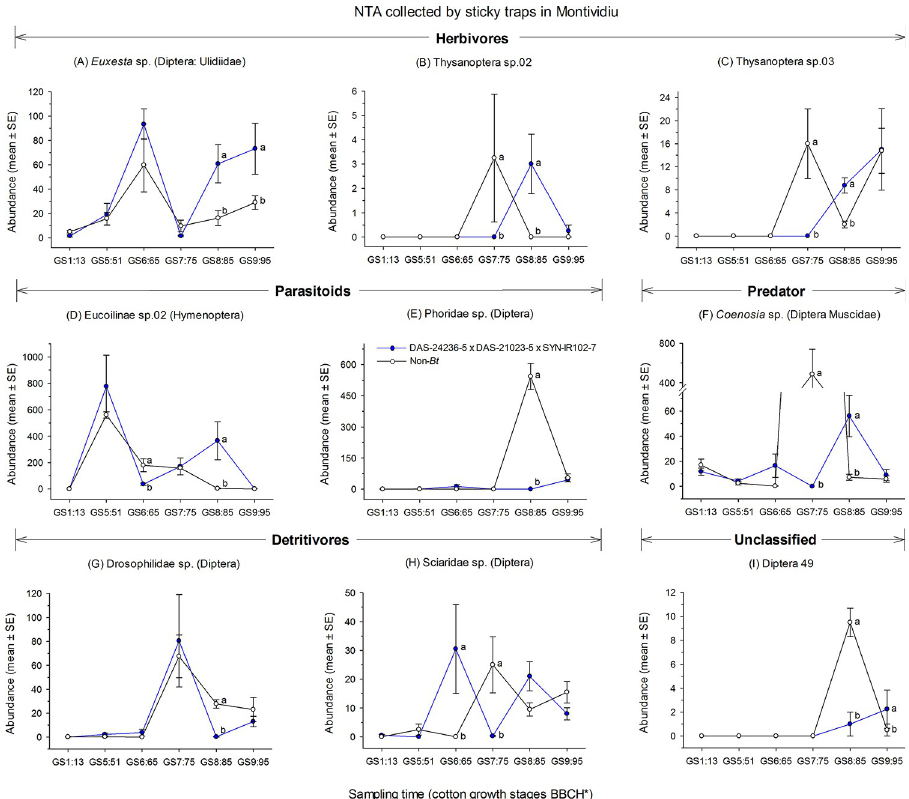
Fig 8. Abundance of aerial-dwelling arthropods collected via sticky card trapping in a cotton trial at Montividiu (2014/2015 cropping season). Means ( ± SE) within sampling time followed by different letters are significantly different by two-way RM-ANOVA test ( α = 0.05). � Phenological growth stages of cotton classified according to Munger et al. (1998). cotton growth stage was lower for DAS-21023-5 × DAS-24236-5 × SYN-IR102-7 plots com- pared with non- Bt cotton (Fig 10). The abundance of the predatory beetle Calosoma sp. at the GS5:51 and GS6:65 cotton growth stages and the ant D . brunneus at the GS1:13 cotton stage were also significantly lower for DAS-21023-5 × DAS-24236-5 × SYN-IR102-7 plots (Fig 10A and 10C). However, for the last sampling time the abundance of D . brunneus was higher in DAS-21023-5 × DAS-24236-5 × SYN-IR102-7 plots compared with non- Bt cotton (Fig 10C). Berlese-Tullgren funnel soil extraction. The RDA for NTAs collected using the Berlese- Tullgren funnel soil extraction method did not identify significant differences at any of the sites in the study: Conchal (F = 2.3; P = 0.748), Indiano´polis (F = 2.5; P = 0.490) and Montivi- diu (F = 2.9; P = 0.396) (Fig 11). High taxon weights for the mite groups, Mesostigmata sp. and Cosmolaelaps sp. at Conchal (Fig 11A), and Oribatida and Mesostigmata sp., along with the beetle from Platypodidae sp., ant Pheidole sp. and Collembola sp. at Indiano´polis (Fig 11B), and Collembola, Oribatida and Mesostigmata sp. at Montividiu (Fig 11C) identified common groups dominant in the soil environment.